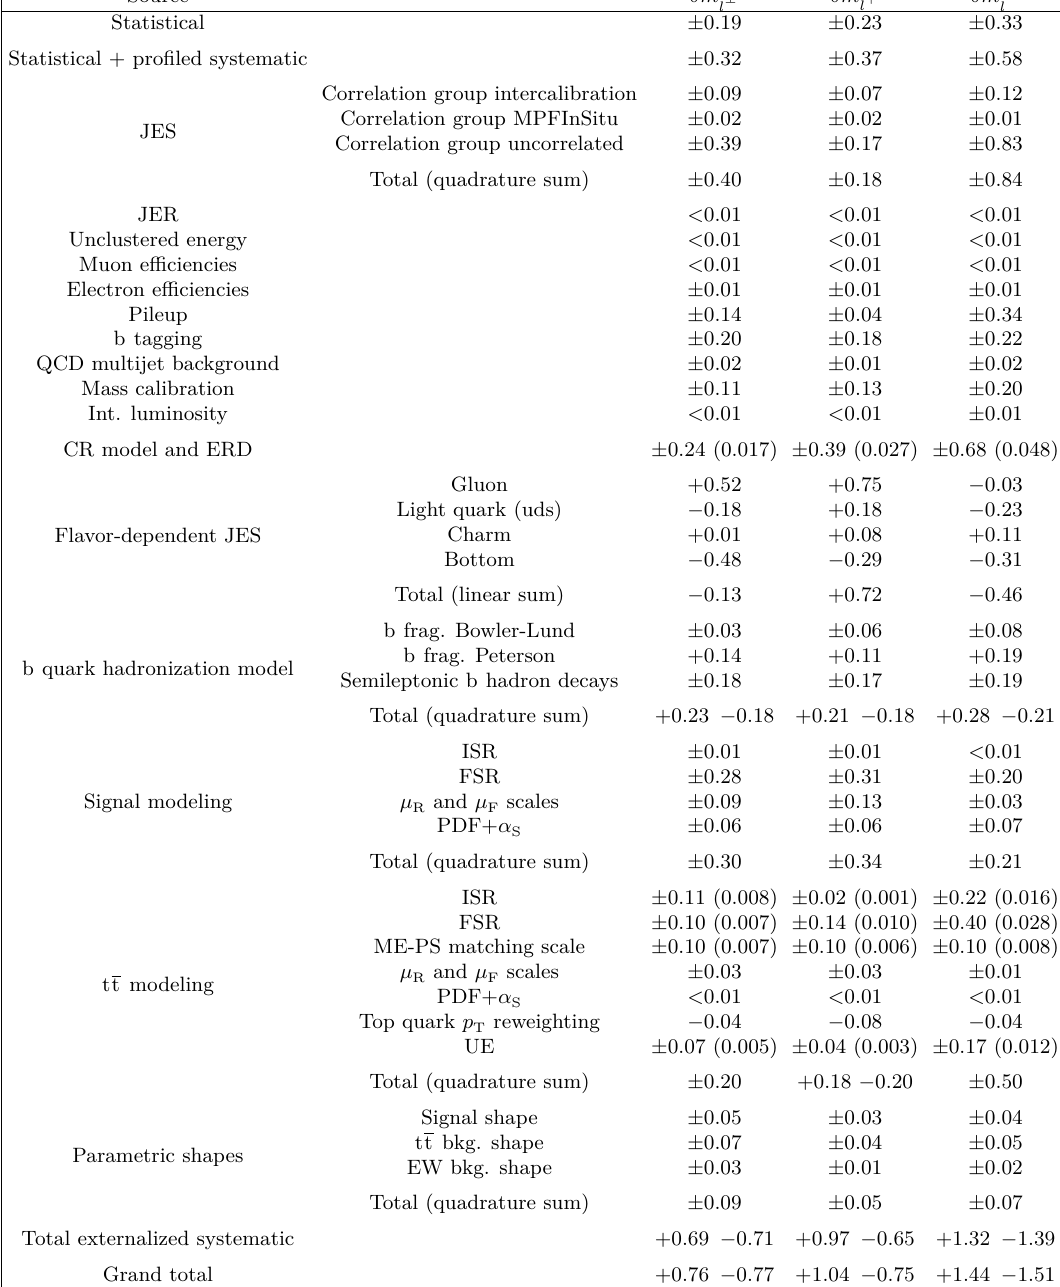
uncertainties in GeV for each final-state lepton charge configuration. Table 3 . Summary of the m t The statistical uncertainties are obtained by performing the fits again in each case while fixing the nuisance parameters to their estimated values from data. With the exception of the flavor- dependent JES sources, the total systematic uncertainty is obtained from the quadrature sum of the individual systematic sources. The amount of statistical fluctuations in the systematic shifts are quoted within parentheses whenever alternative simulated samples with systematic variations have been used. These are determined from 1000 pseudo-experiments in each case. Entries with < 0 . 01 denote that the magnitude of the systematic bias is less than 0 . 01